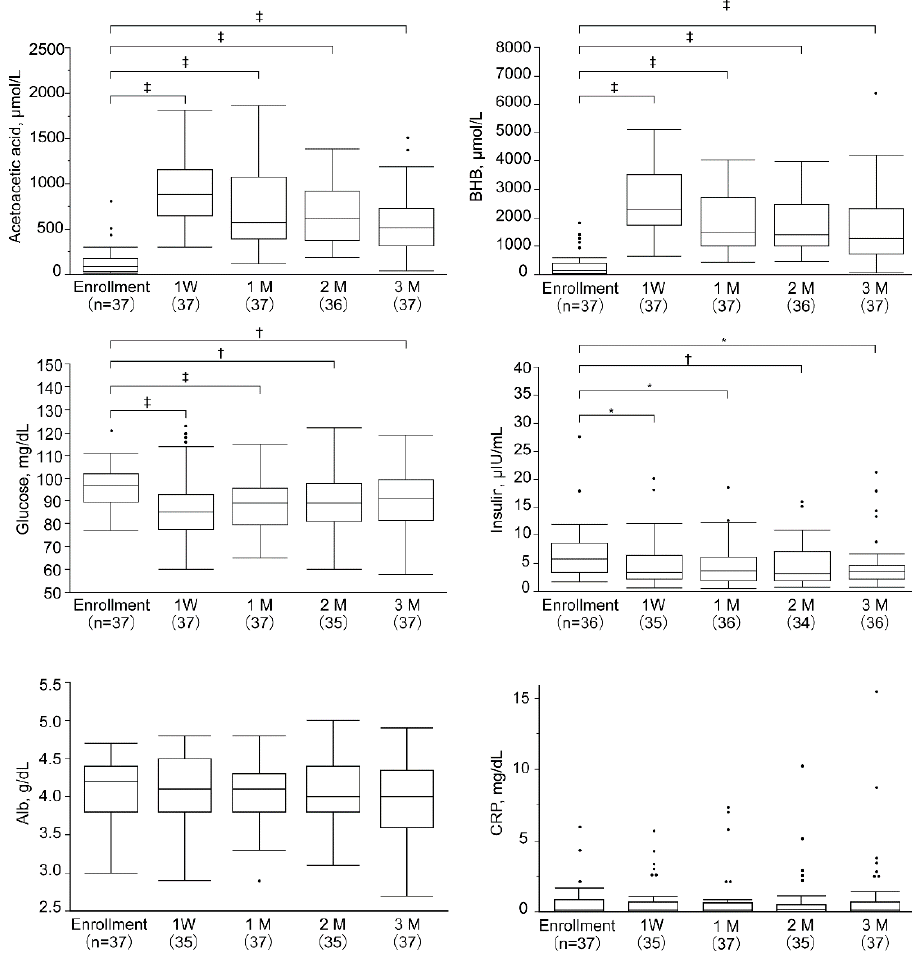
Figure 2. Blood data of patients after the ketogenic diet. Box plots represent medians and interquartile ranges; whiskers indicate range of values that fall within 1.5 box lengths. Footnotes indicate significant differences (Wilcoxon signed-rank test; enrollment vs. 1 week and 1, 2, and 3 months. * p < 0.001, † p < 0.01, ‡ p < 0.05). BHB, β -hydroxybutyric acid; Alb, albumin; CRP, C-reactive protein.